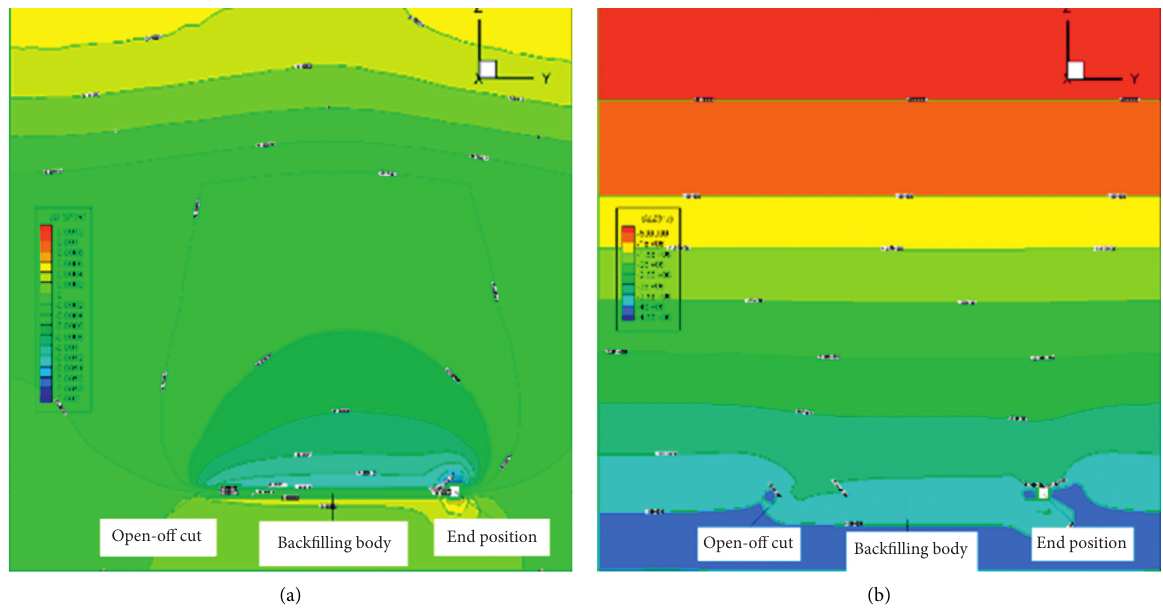
Figure 12: Movement of overlying strata when the working face advances for 100m under the elastic modulus of gangue of 10GPa. (a) Displacement vector of surrounding rock. (b) Distribution of vertical